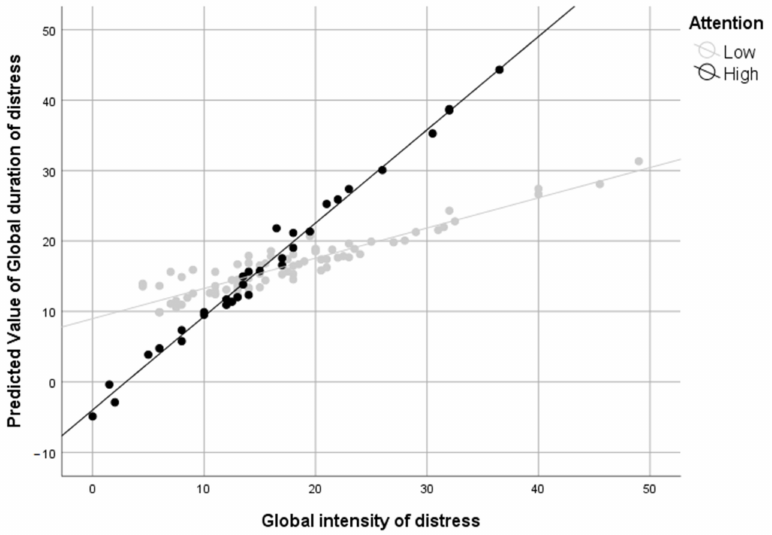
Figure 1. Predicted values of global duration (weeks) of distress from global intensity of distress and attention, controlling for sex and